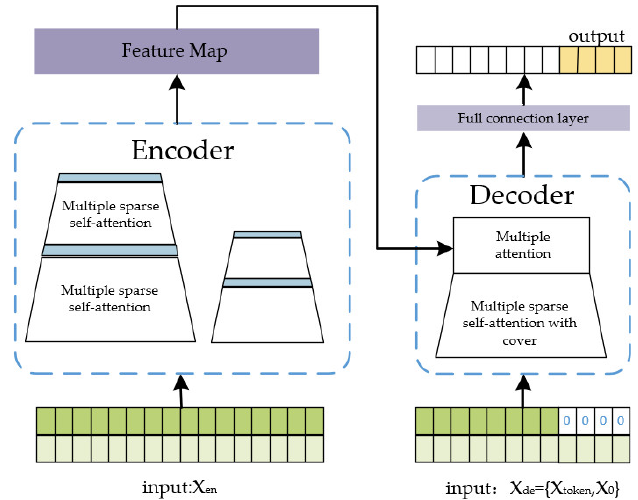
Figure 5. Overall structure of Informer.